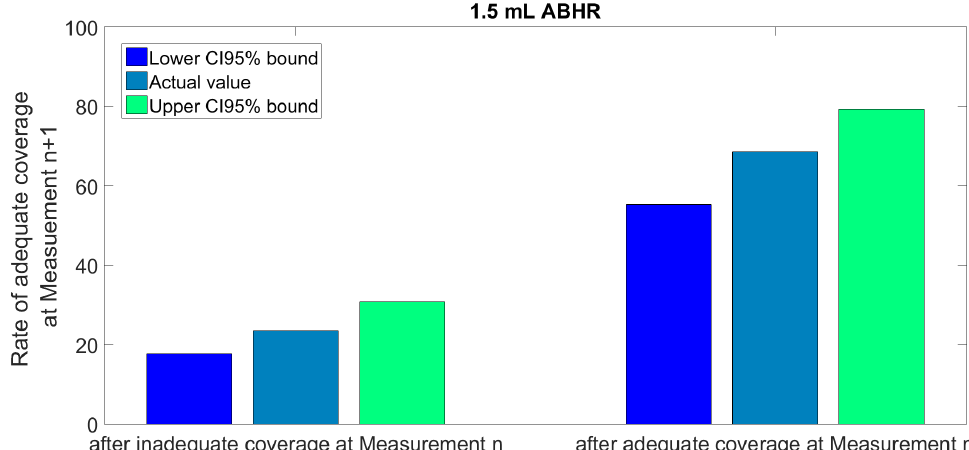
Figure 6. Overall statistics of consecutive measurements using 1.5 mL ABHR.